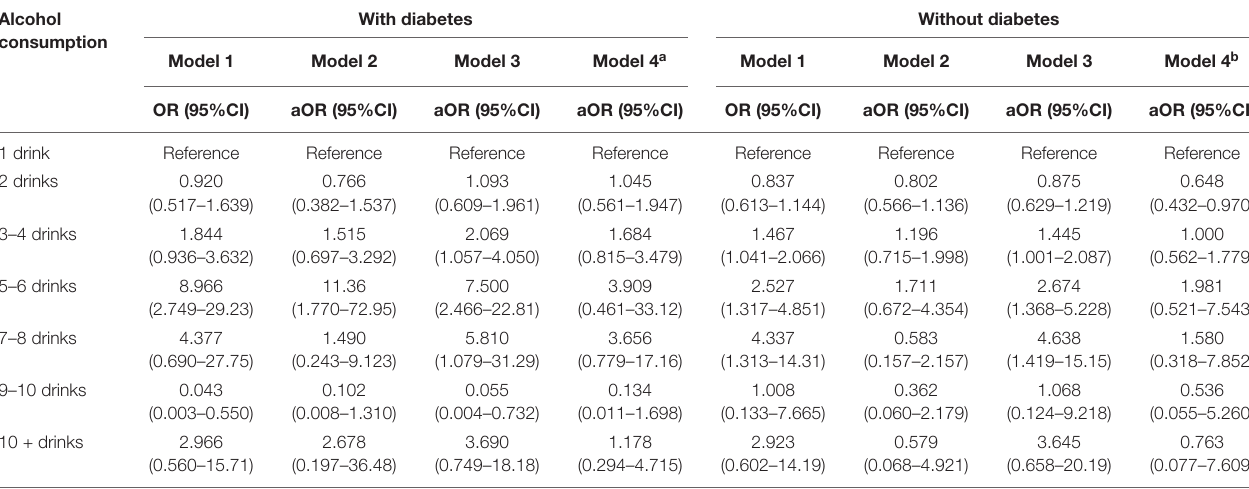
Model 1: crude OR (95%CI). Model 2: adjusted for demographic variables. Model 3: adjusted for comorbidity variables. Model 4 a : adjusted for all significant variables in Supplementary Table 4 (age, race, education, social attendance, CKD). Model 4 b : adjusted for all significant variables in Supplementary Table 4 (age, gender, race, education, income, physical activities, social attendance, hypertension,